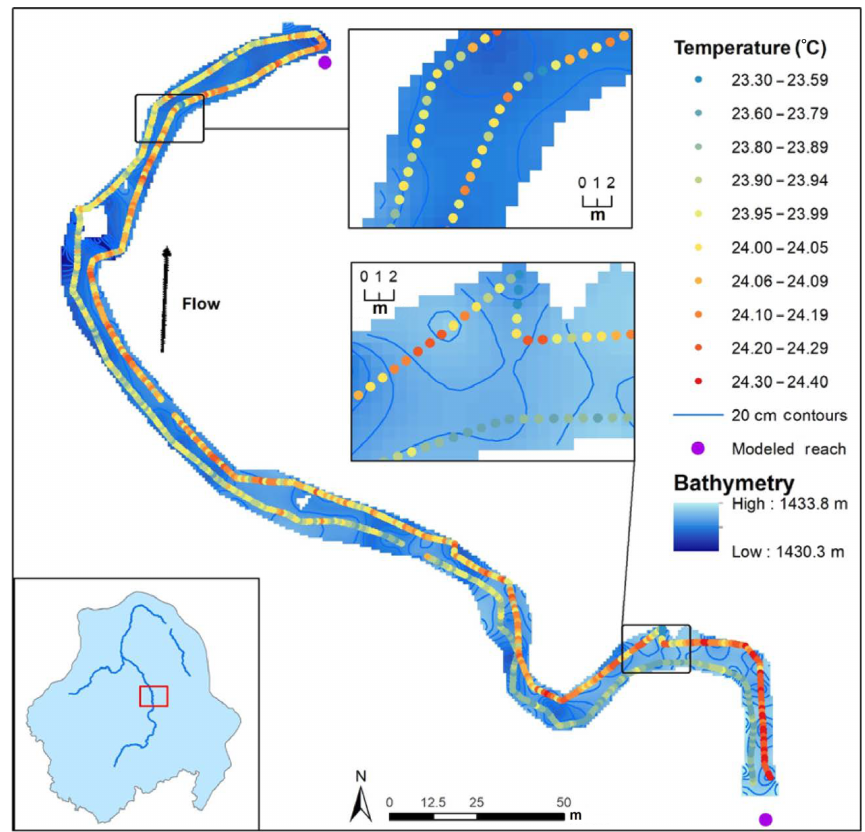
Figure 3. East Walker River daily maximum stream temperatures on 21 June 2015. Insets show details of spatial temperature variability. Modeled reach points represent the division between 300m modeled